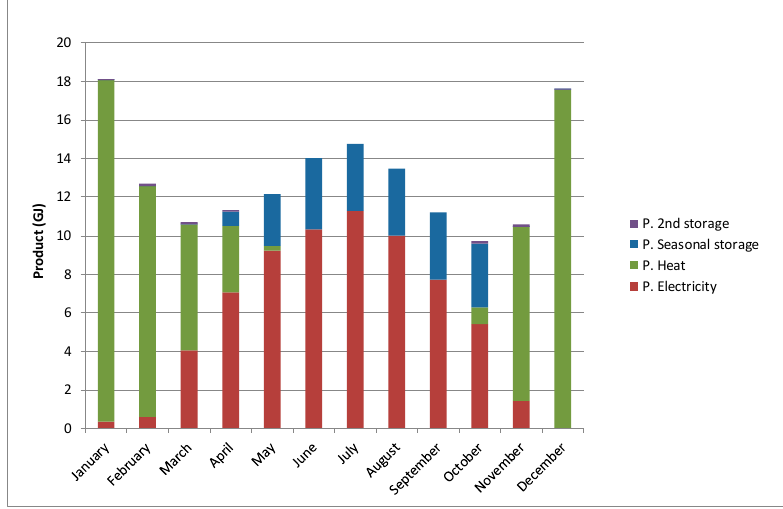
Figure 6. Complete system: Product.